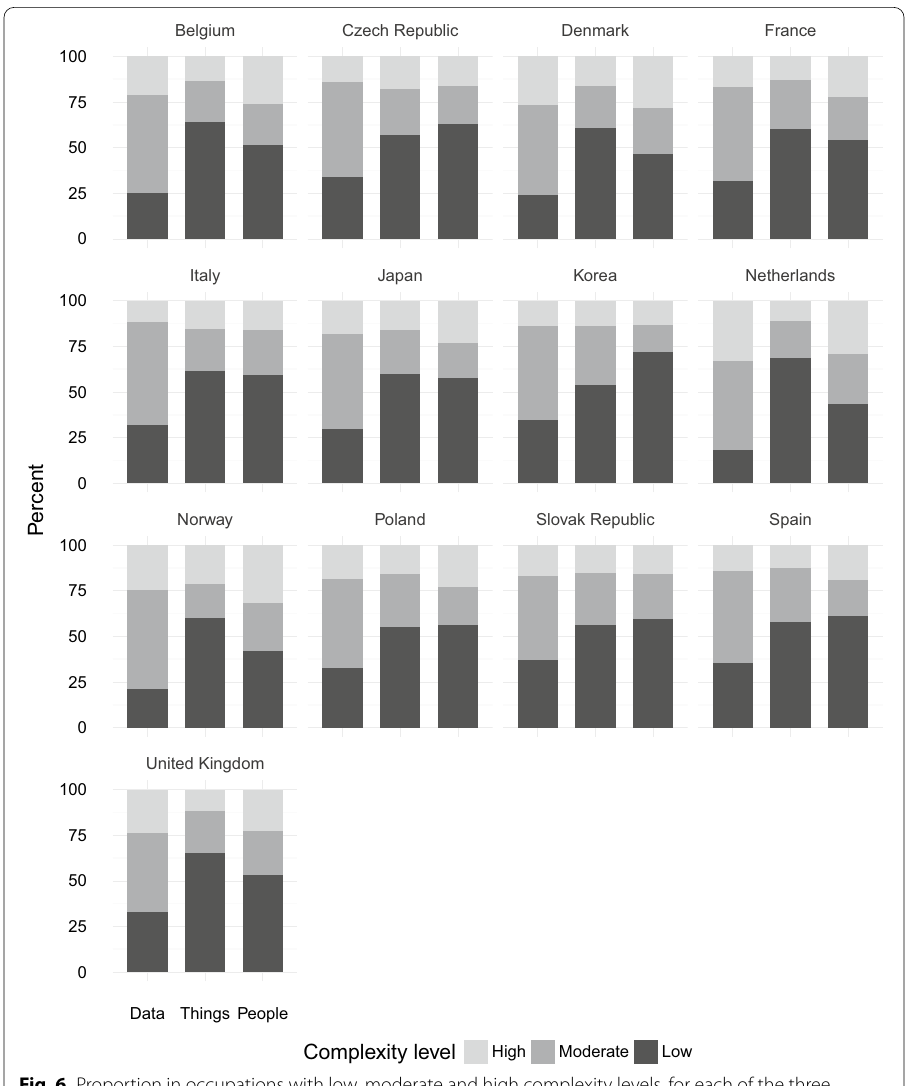
Fig. 6 Proportion in occupations with low, moderate and high complexity levels, for each of the three complexity dimensions (Source: PIAAC 2012, DOT index, ISCO-08